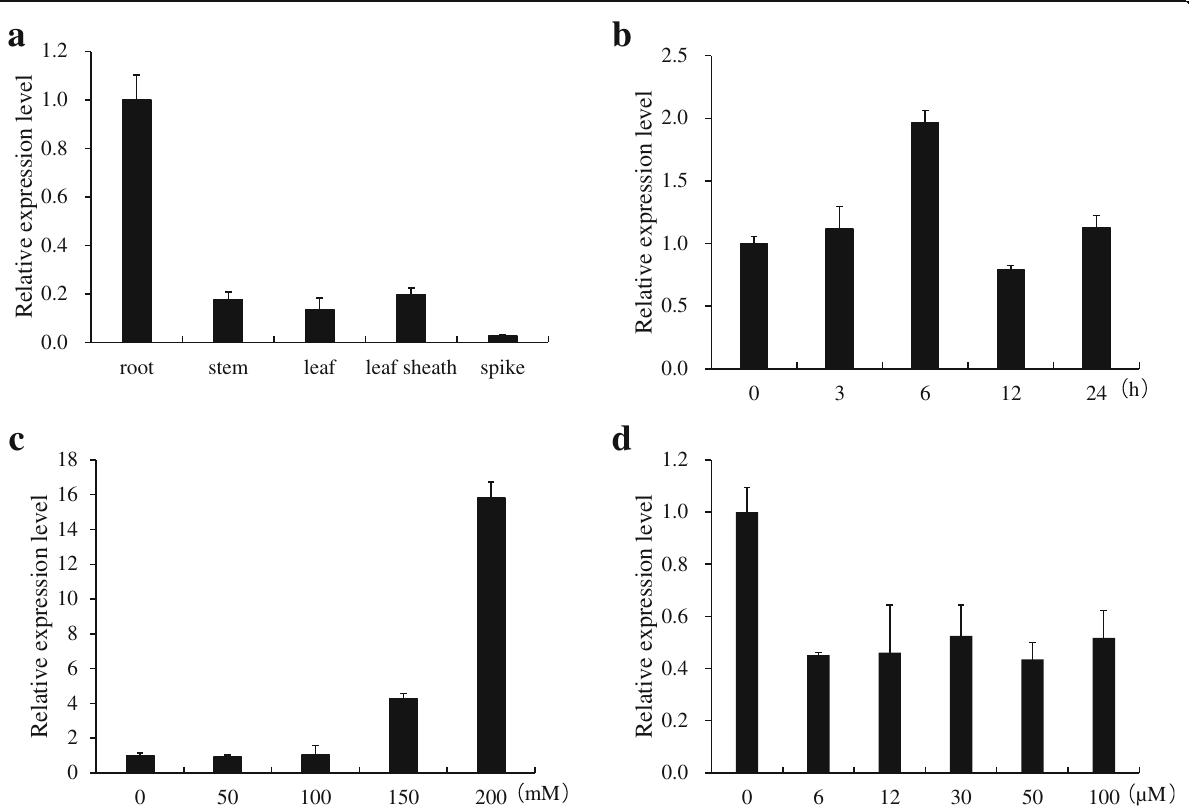
Fig. 1 Expression patterns of OsNAC45 . a Expression of OsNAC45 in various tissues of rice cultivar Nipponbare. b Time-course expression pattern of OsNAC45 in rice roots. Seedlings were exposed to 100mM NaCl for 3, 6, 12 or 24h. c Dose-dependent expression of OsNAC45 in rice roots during salt treatment. Seedlings were exposed to different concentrations of NaCl for 12h. d Dose-dependent expression of OsNAC45 in rice roots during ABA treatment. Seedlings were exposed to different concentrations of ABA for 6h. Data are means ± SD of three biological